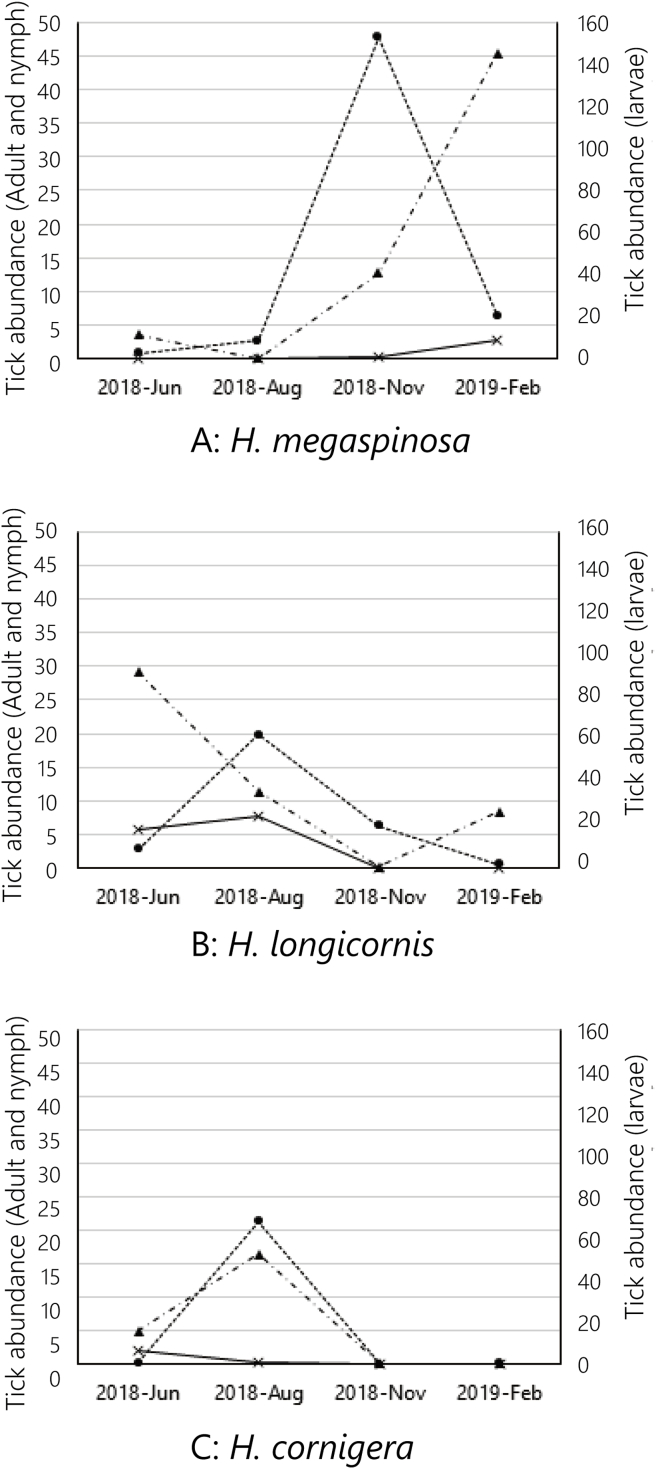
Seasonal changes in tick abundance of the dominant species (A) H. megaspinosa, (B) H. longicornis, and (C) H. cornigera on Niijima Island. (Broken line with black dot: Larvae, Dotted-dashes line with back triangles: Nymphs, Solid line with crosses: Adults).